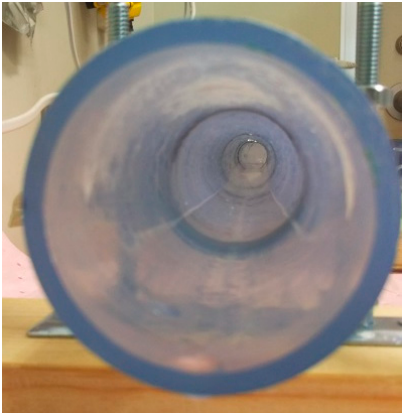
Figure 6. Sewer pipe blockage condition on the 7th day from the simulated experiment (Observation point 4).